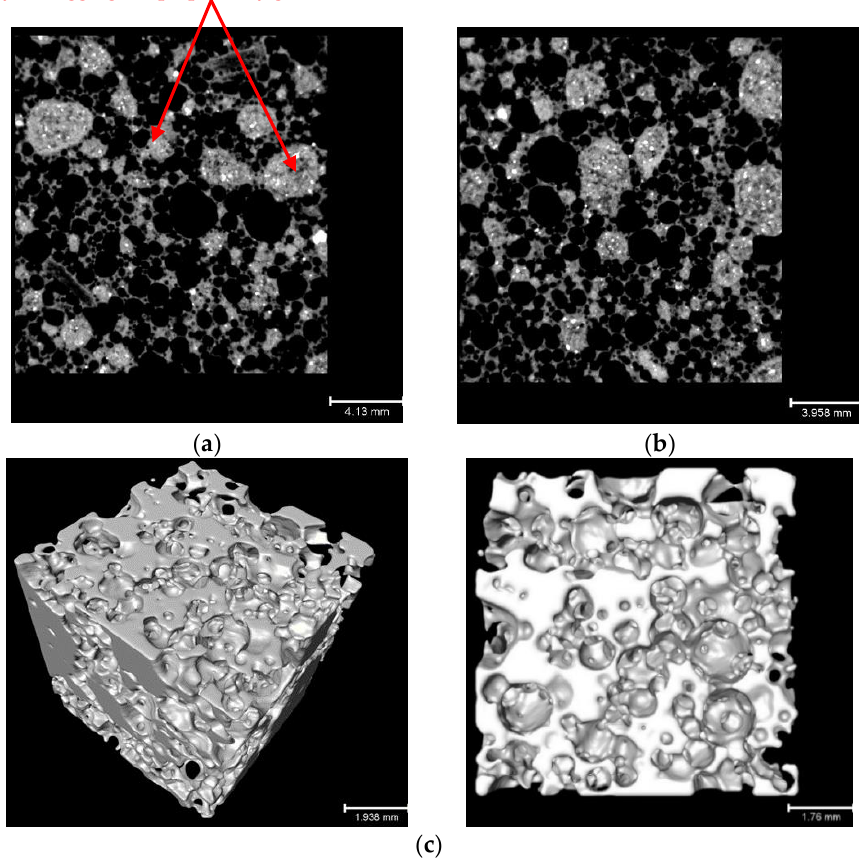
Figure 11. ( a ) Cross-section in X – Z direction; ( b ) cross-section in Y – Z direction; ( c ) three-dimensional (3D) segmentation of inner section.